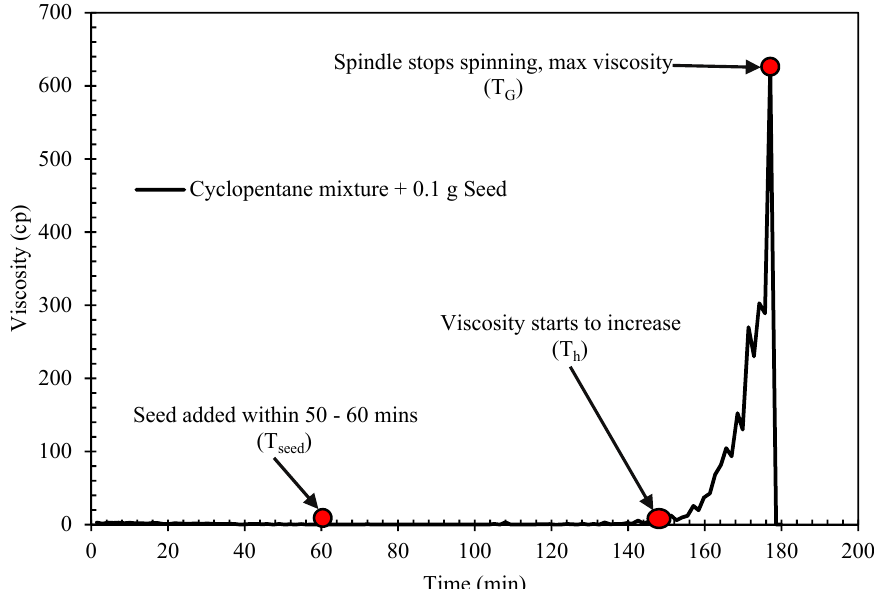
Figure 3. Typical hydrate rheology profile of cyclopentane mixture (Blank) with 0.1 g seed at 2 °C.